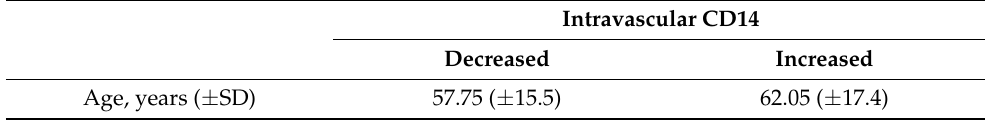
Table 7. Age distribution according to different groups of soluble